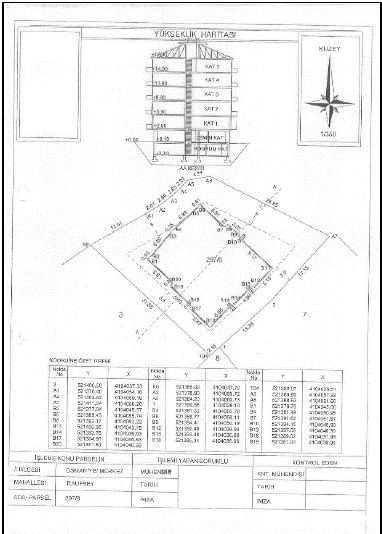
Figure 5. Elevation location chart (sample form Osmaniye, Turkey)